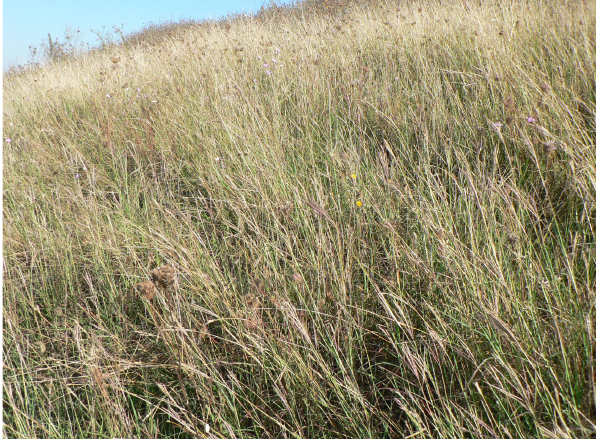
Fig. 1. Physiognomy of the grasslands edified by Dichanthium ischaemum (original)